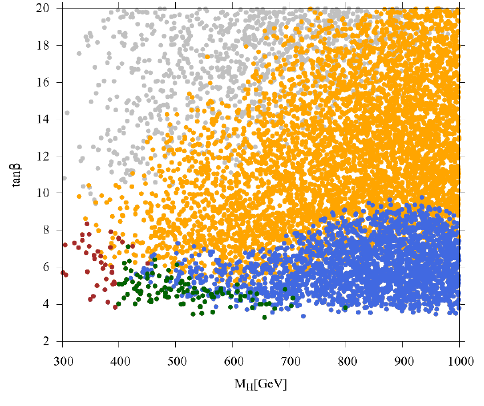
M 2 (cid:22) < 10 GeV, M H=A > ( M j (cid:0) j